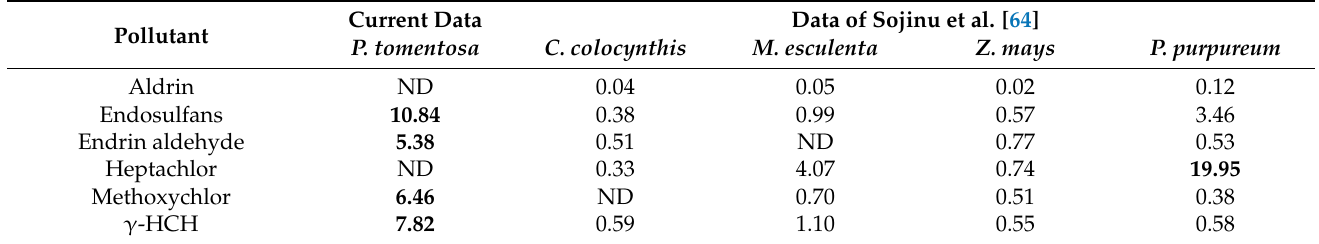
Table 4. BCF s for OCPs accumulated in AGB of different energy